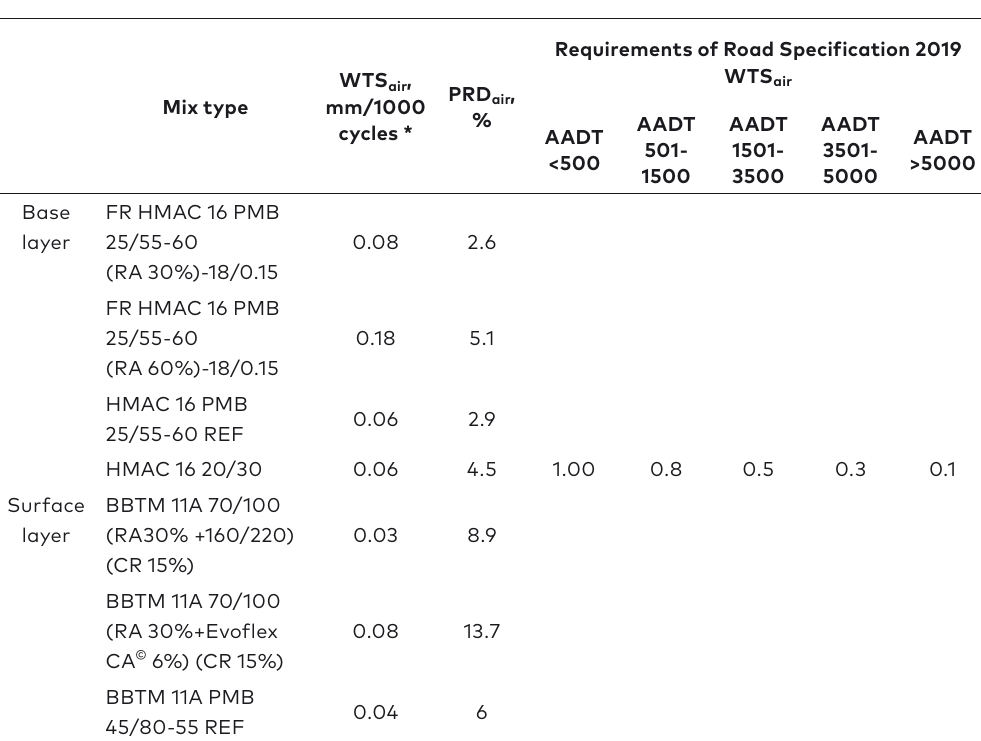
Table 10. Wheel tracking test performance results for the tested samples against the requirements of Road Specification